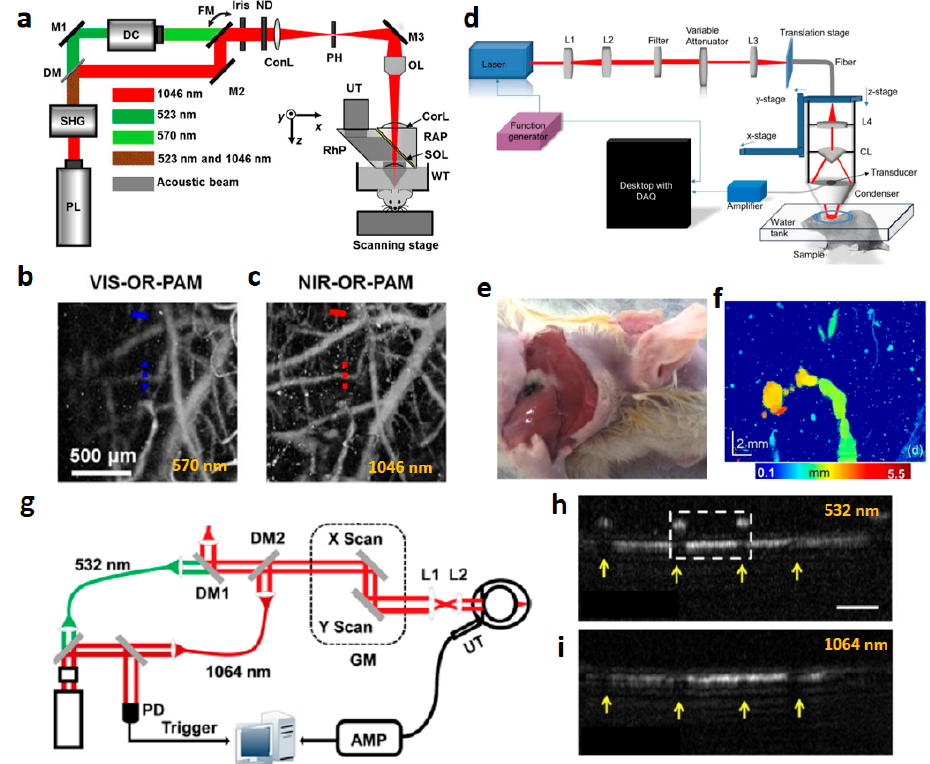
Figure 3. Photoacoustic microscopy (PAM) with NIR light. ( a ) Schematic of NIR optical-resolution photoacoustic microscopy (NIR-OR-PAM). ( b , c ) OR-PAM images of a mouse brain of VIS-OR-PAM and NIR-OR-PAM, respectively. ( d ) Schematic of NIR acoustic-resolution photoacoustic microscopy (NIR-AR-PAM). ( e , f ) Photography and AR-PAM image of sentinel lymph nodes (SLNs) with a black ink, respectively. ( g ) Schematic of NIR optical resolution-photoacoustic ophthalmoscopy (OR-PAO). ( h , i ) NIR-OR-PAO images of a mouse retinal blood vessels at 532 nm and 1064 nm, respectively.